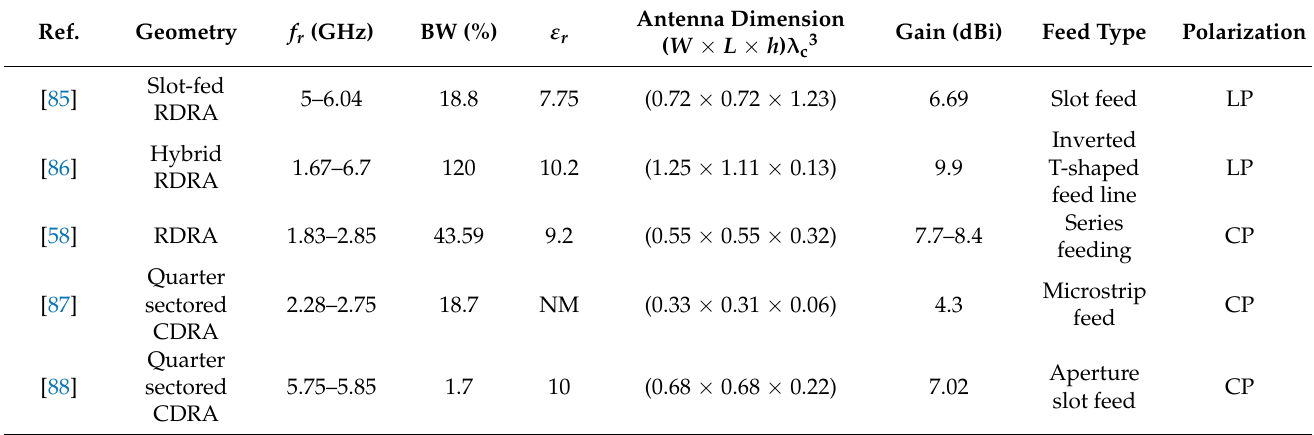
Table 7. Comparison between various DRAs for RF energy harvesting.